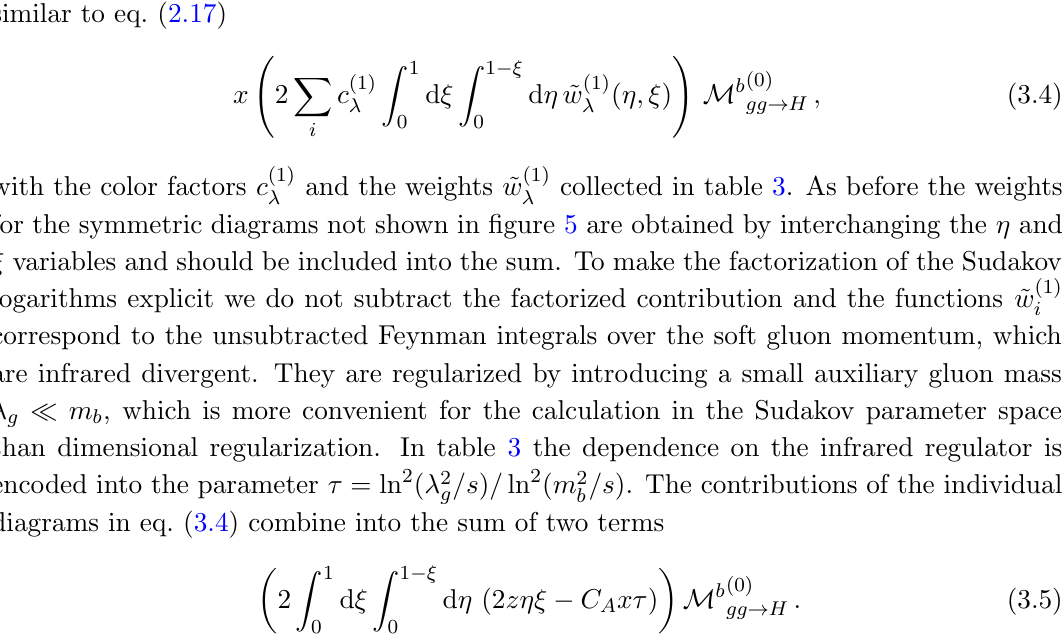
for the diagrams in (cid:12)gure 5. (cid:21)